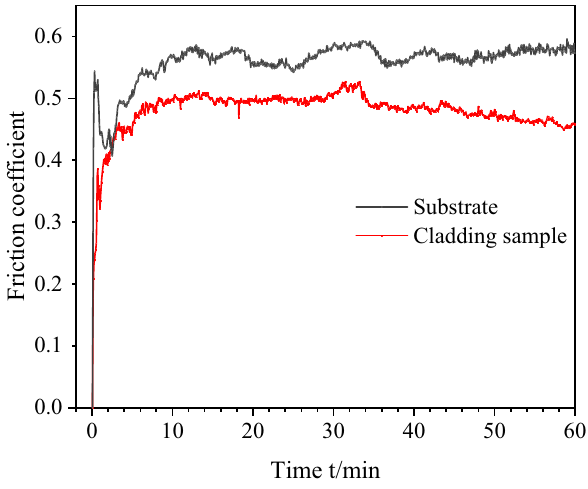
Figure 4: Friction coe ffi cient curve of SUBs and cladding